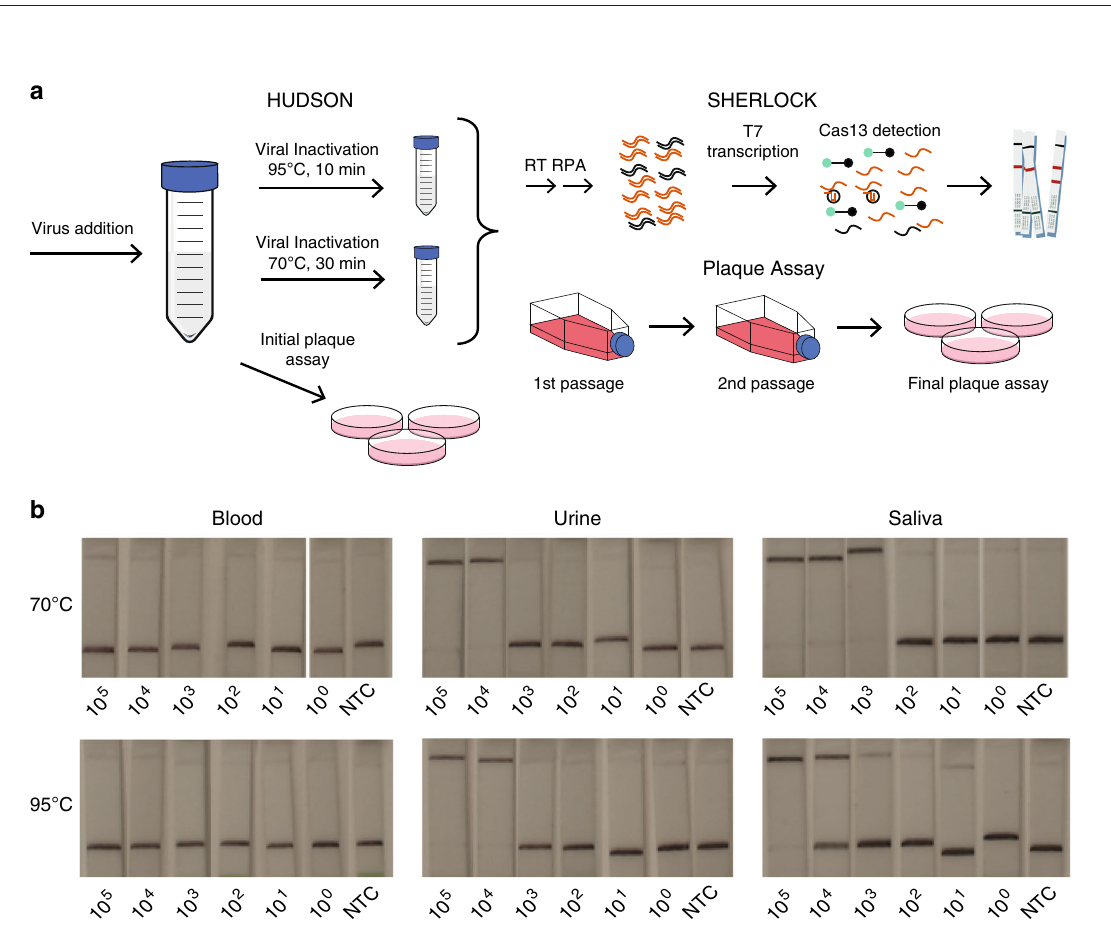
Fig. 3 HUDSON safety testing. a Schematic overview of the HUDSON, SHERLOCK inactivation validation. Viral inactivation includes dilution with EDTA : TCEP and a 20 min 37 °C inactivation of nucleases. All fi nal results were determined using lateral fl ow due to the inability to carry out appropriate fl uorescent analysis in the BSL4 facility. b Lateral fl ow detection of spiked blood, urine, and saliva inactivated at either 70 °C or 95 °C. Serial dilution shown are PFU/mL. All assays were carried out in the BSL4